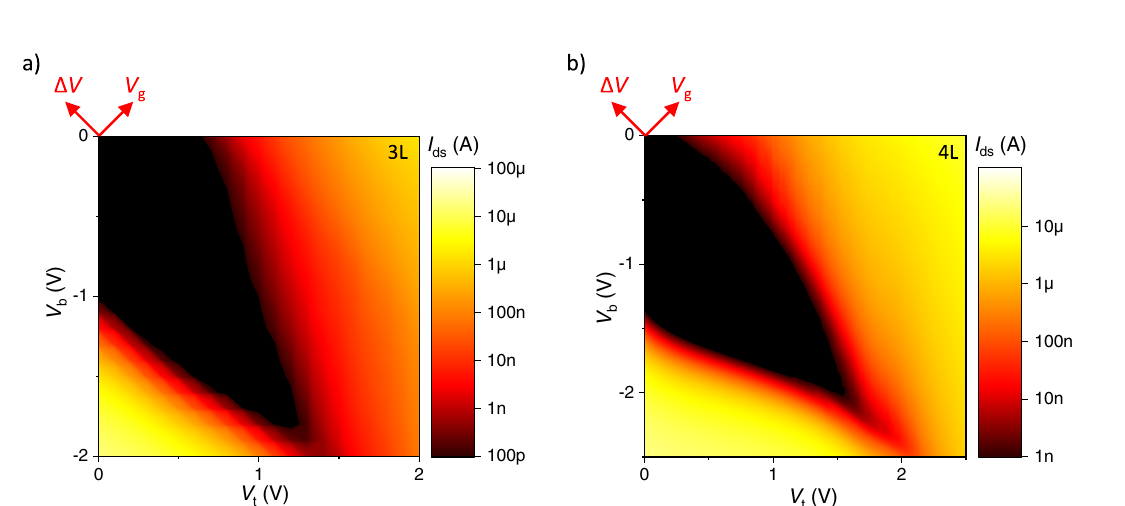
Fig. 3 | Transport measurement of dual ionically-gated bilayer WSe 2 . a Map of I V V ds vs. ( b , t ) for bilayer WSe 2 (sample #1). The axes of the coordinate system de fi ned by V g ≡ V b + V t and Δ V ≡ V b – V t , are indicated. The diagonal lines indicate constant Δ V from 2V to 4V. b Line scans corresponding to the slices of Δ V refer- enced in the map. The bandgap, E 2L , at each Δ V is obtained from the difference